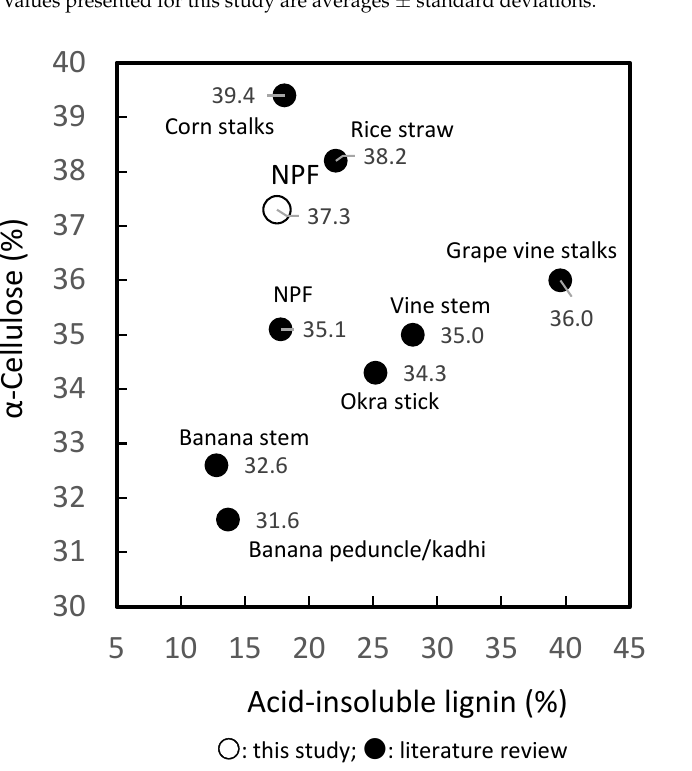
Figure 2. Tamunaidu and Saka [17] revealed that various parts of nipa palm contain a syringyl (S)-, guaiacyl (G)-, or p -hydroxyphenyl (P)-type lignin, and a large S to G ratio. The proportion of S units is greater than that of G units of lignin, which indicates that the wood material can easily be delignified [49]. These studies also showed that the chemical composition of all parts of nipa palm was very similar to that of oil palm. The acid-soluble lignin content obtained in this study using the TAPPI method at 205 nm and 110 L/g cm absorption coefficient is lower than the values recorded in previous studies for the same material, namely 0.8 ± 0.5% vs. 1.9% [17]. The differences in the measured values using the UV-spectrophotometric method are caused by the biomass feedstock, solubility in the solvent, differences in absorbance of the G-S-P type of lignin, and experimental factors [53]. However, the acid-insoluble lignin content is higher than the acid-soluble content in the NPFs, which contributed to the total lignin. Future studies can include a determination of the absorption coefficient, because it is important for